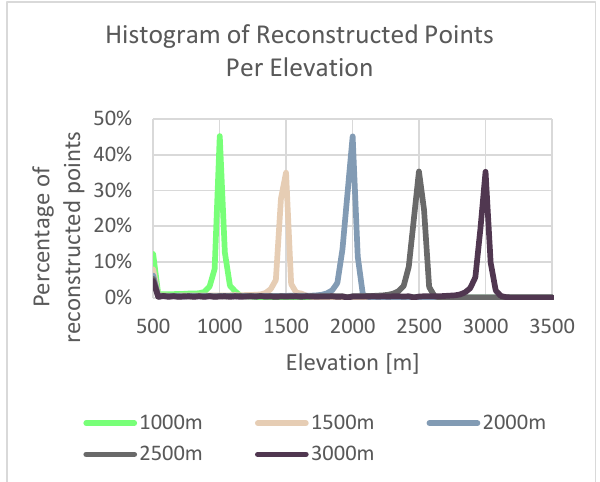
Figure 11. Histogram of the reconstructed points per